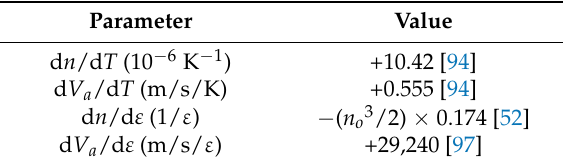
Table 4. Material response to changes in T and ε for pure glass SiO 2